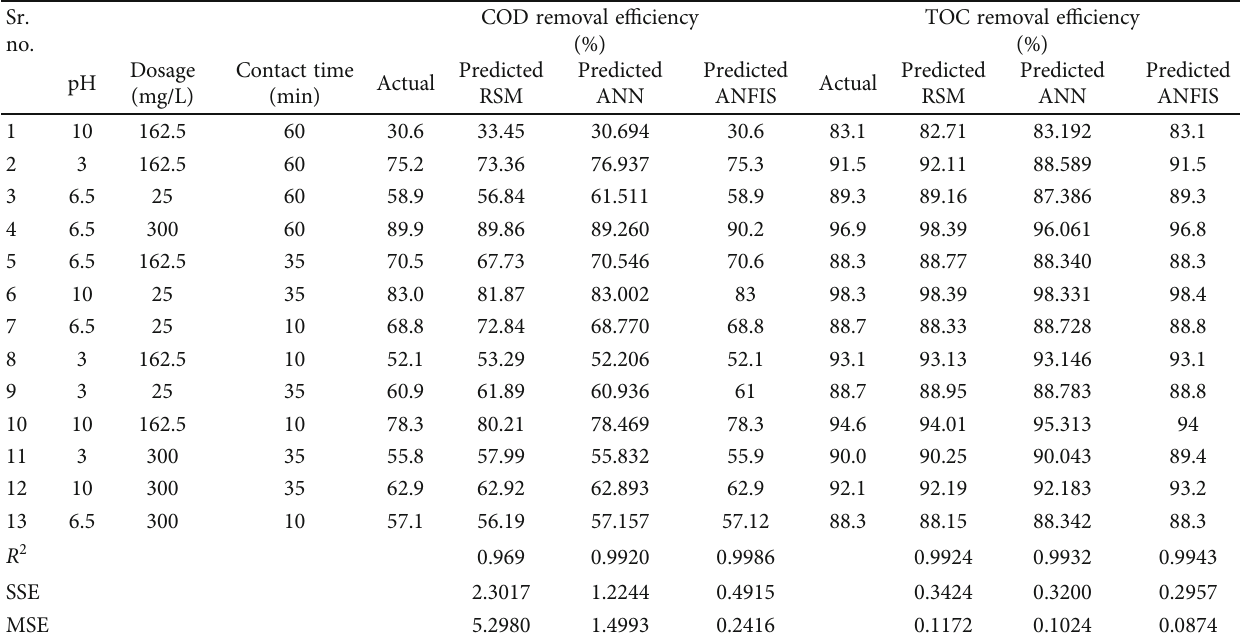
Table 7: Experimental and predicted results of COD and TOC adsorption using RSM, ANN, and ANFIS and statistical analysis of predicted results. Sr.